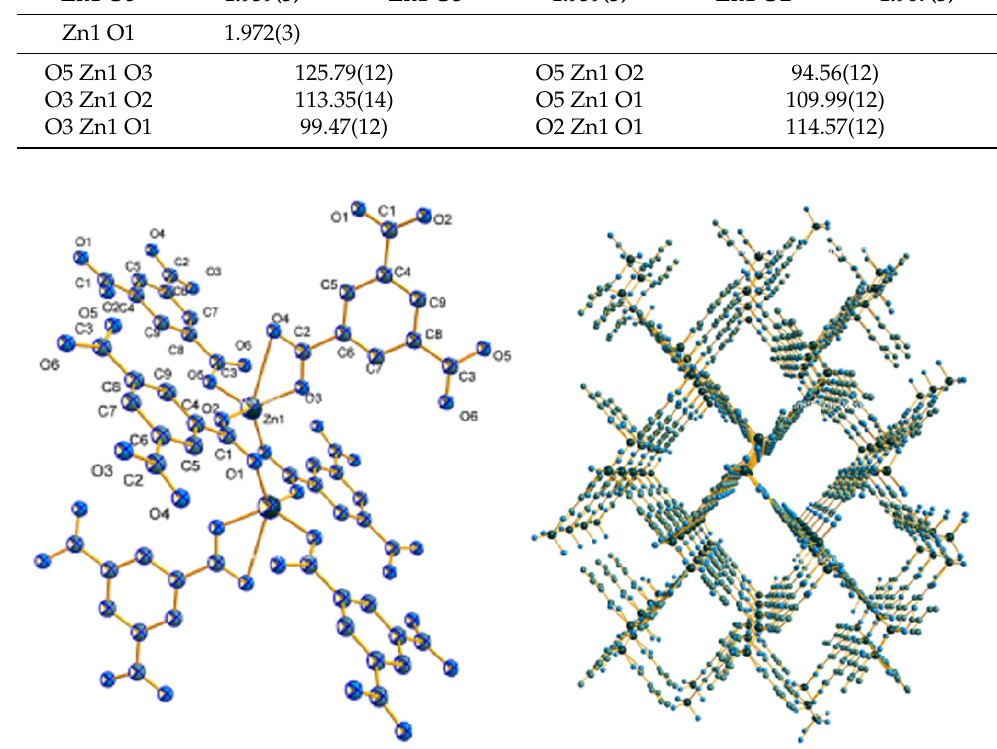
Table 2. Selected bond lengths(Å) and angles(°) for MOF Zn(BTC) 4 .